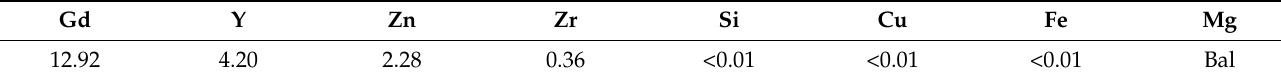
Table 1. Chemical composition of Mg-Gd-Y-Zn-Zr alloy (wt. %).